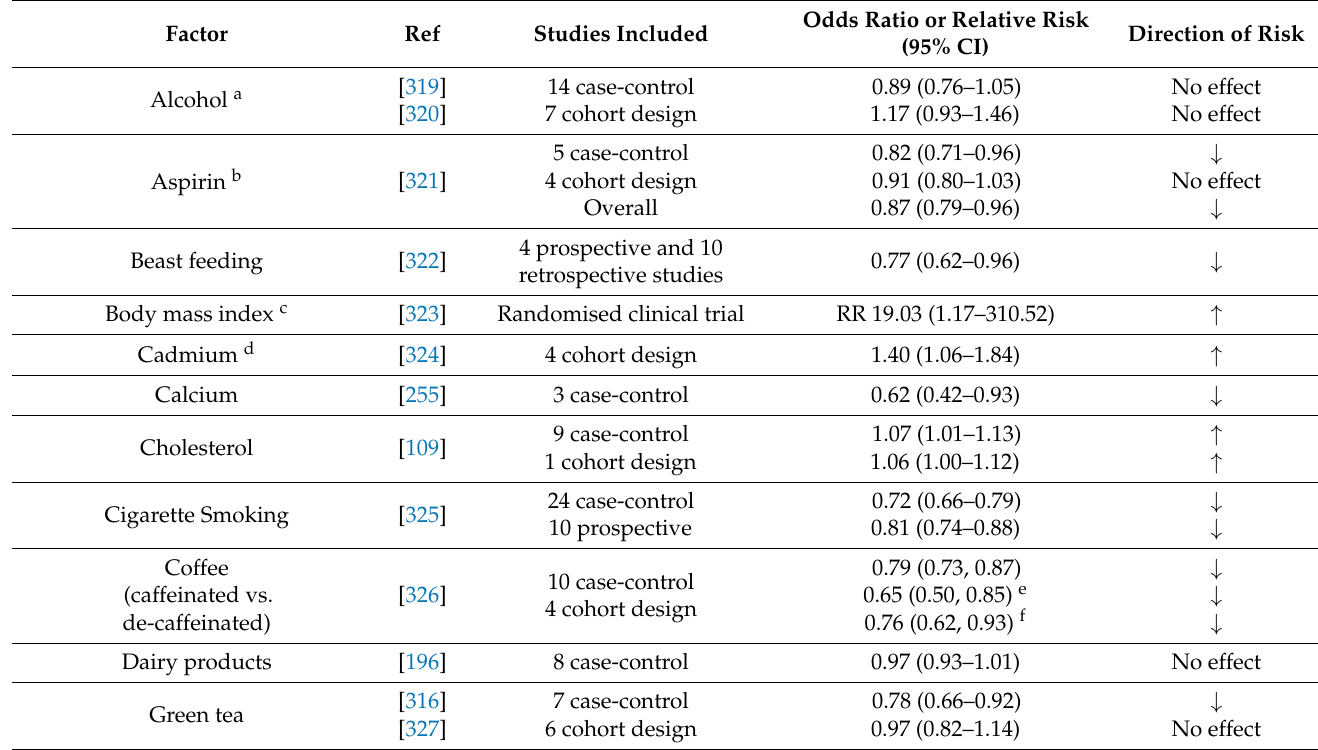
Table 4. Risk factors tested in patients with endometrial cancer and analysed through meta-analysis or Cochrane